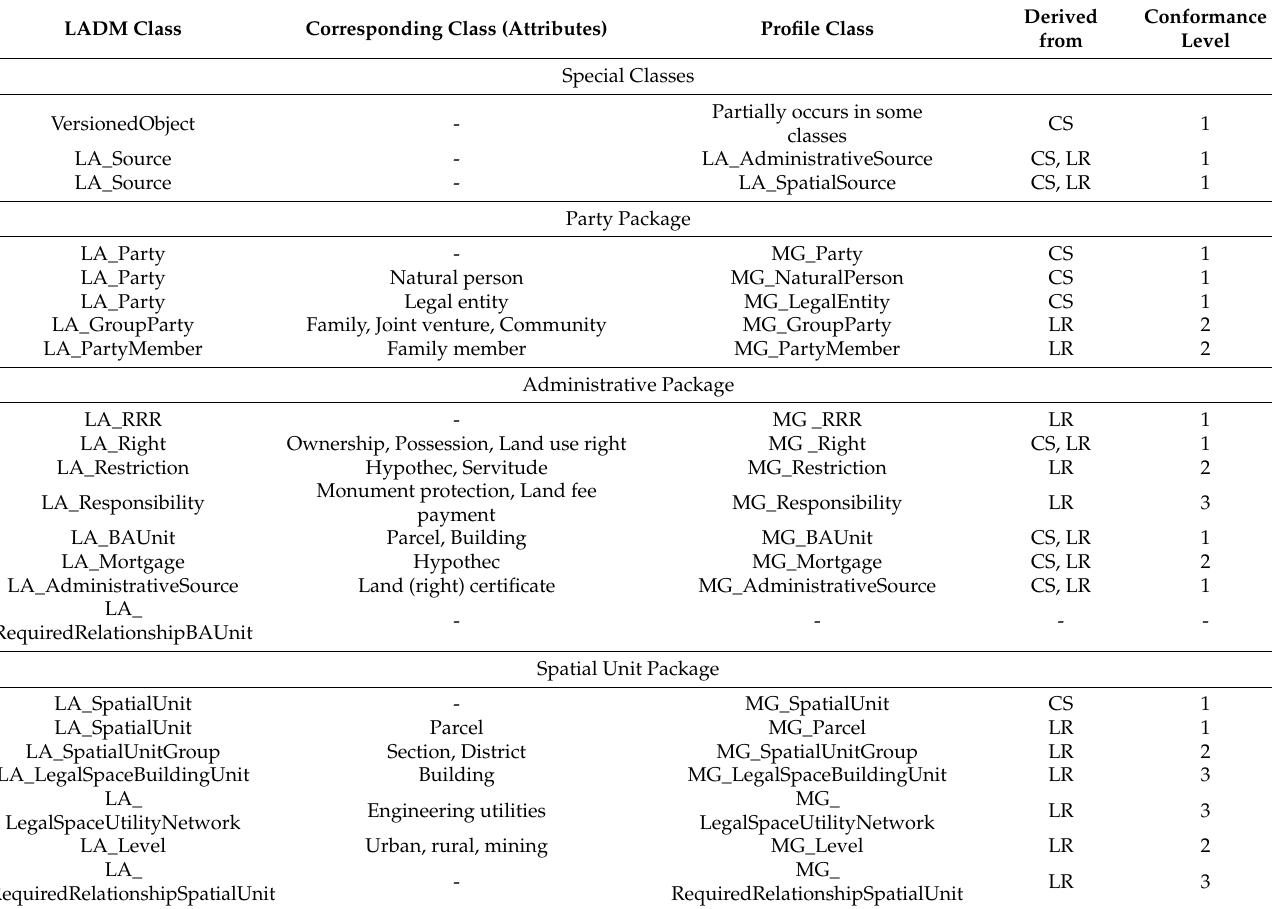
Table 2. LADM conformance test, including corresponding classes of the Mongolian cadastre.